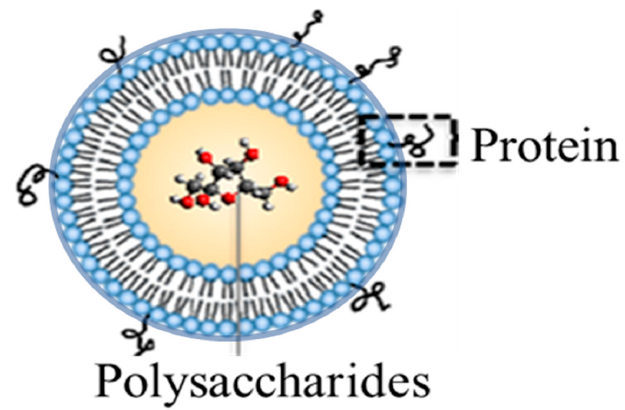
Figure 1. Liposomal Encapsulation of Polysaccharides (LEPS) system featuring polysaccharide immunogen content within the liposomal structure and proteins (either immune-stimulating or antigenic) noncovalently affixed to the outer surface via mechanisms that include metal-chelation (as in the case of the enclosed study).